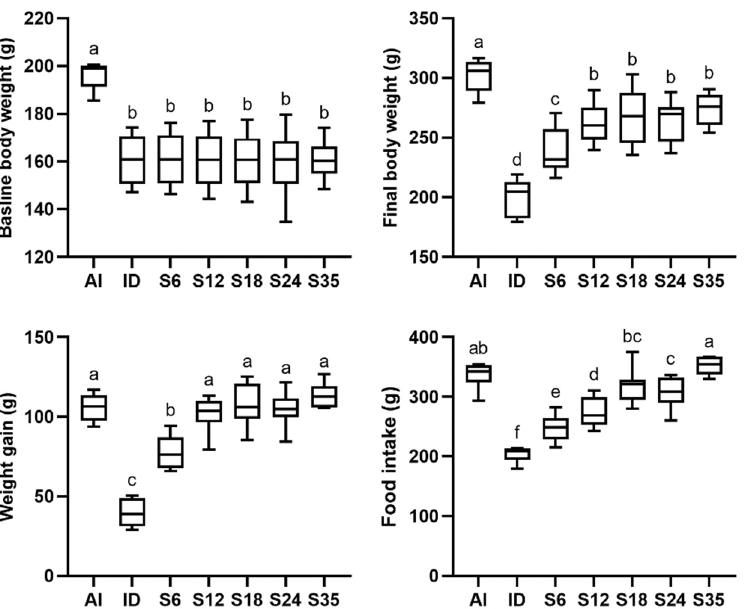
Figure 1. Effects of different doses of iron supplementation on body weight and food intake in iron-deficient rats. Values are presented as median (interquartile range, IQR). n = 6–8 per group. Values not sharing the same letters are significantly different at p < 0.05. Baseline: the final day of 3-week iron depletion before iron supplementation; Final: after 2-week iron supplementation.